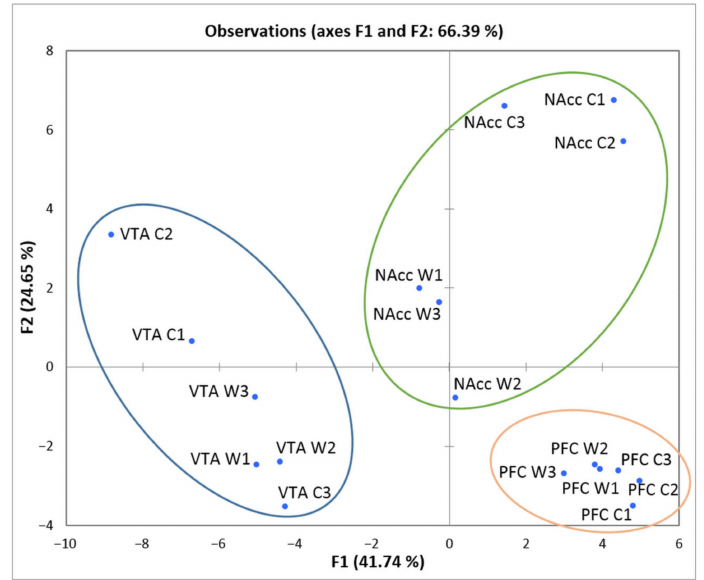
Figure 5. PCA plot based on covariation of genes using the expression profiles of 48 Slc genes across 18 samples, which comprised RNA-Seq FPKM data for three brain regions. Ovals correspond to brain regions. W1, W2, W3: winners; C1, C2, C3: controls; VTA: ventral tegmental area, NAcc: nucleus accumbens; PFC: prefrontal cortex. The figure shows a distinct clustering of the three brain